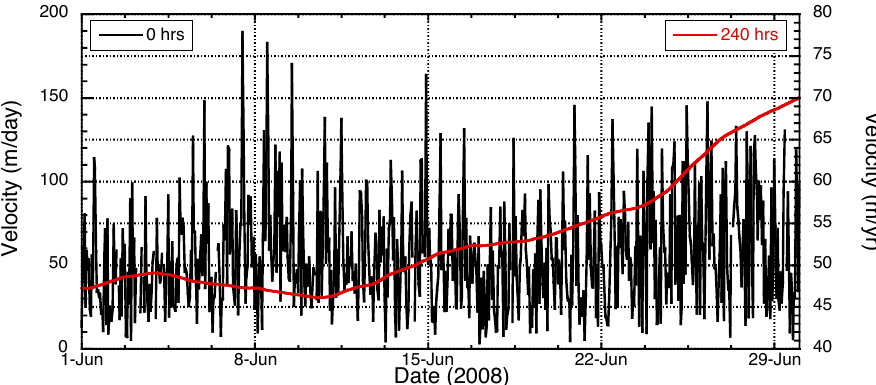
Fig. 7. Time series of velocity measurement of NB4 for June 2008. The black line illustrates the velocity when no averaging is applied, the red line when a running average of 240h is applied. Note that the unit of velocity for the not averaged velocity is mday − 1